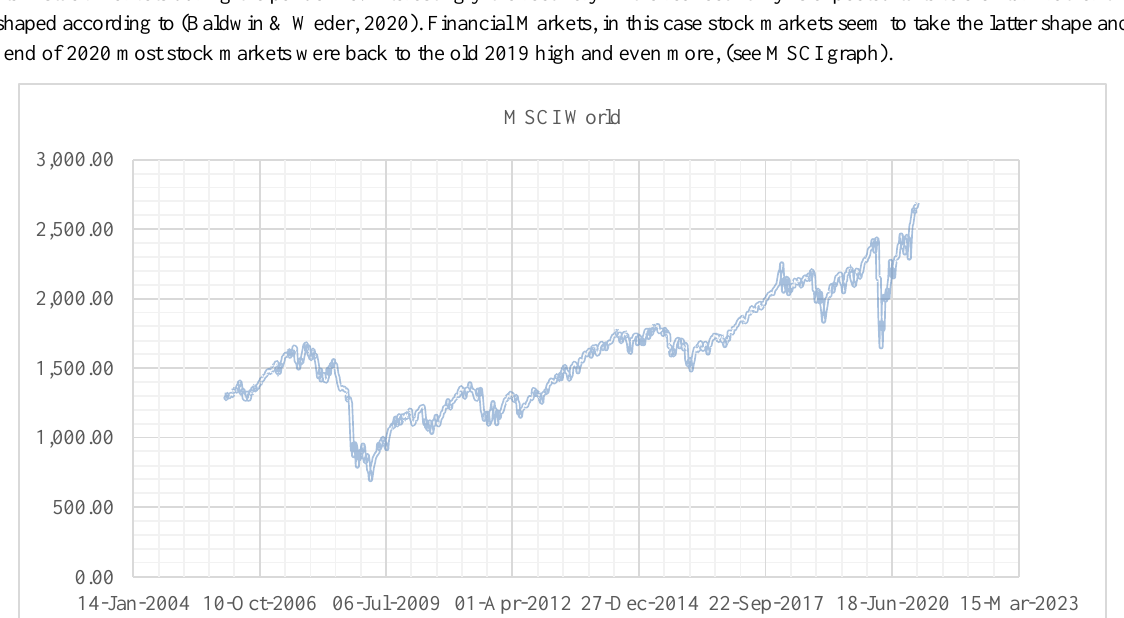
Figure 1: MSCI Global Index Movement; Source: Thompson Reuters,